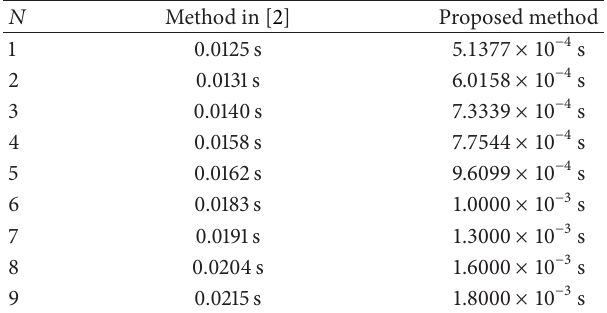
Table 2: Mean online computation time for each control step.